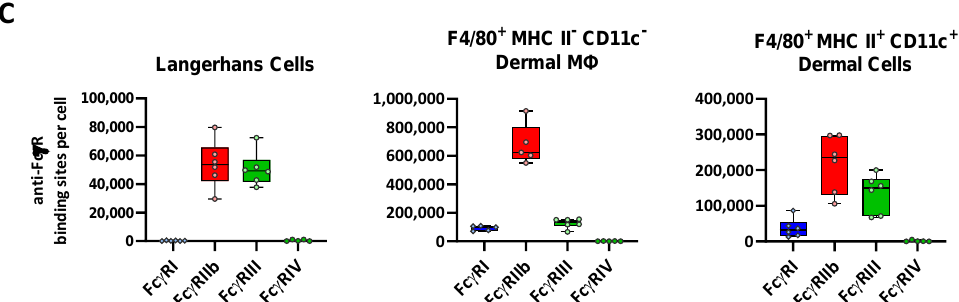
Figure 5. Characterization of the Fc γ R expression on skin macrophage subsets. ( A ) Shown is the gating strategy for the identification of Langerhans cells. CD45-positive populations among single viable cells from an enzymatically digested epidermis were examined for expression of the surface markers CD11b and F4/80. Among CD11b and F4/80-double-positive cells, Langerhans cells were identified by a pronounced expression of Langerin. The histogram inset in the right panel depicts their MHC II expression by comparing the fluorescence in the samples without (FMO, grey histogram) and with anti-MHC II antibody (blue histogram). ( B ) Gating strategy for Langerin-negative F4/80-positive dermal cells. Single viable cells from enzymatically digested and dermis-enriched skin were analyzed regarding their CD45 and Langerin expression to exclude Langerhans cells among the CD45-positive leukocytes. Among the CD45 + Langerin-negative cells, two subpopulations within the CD11b and F4/80-positive cells were distinguished based on a high or low level of MHC II expression (depicted in blue or red), respectively. Both population were then examined for CD11c expression. Inset: Microscopic analysis of the sorted MHC II − CD11c − DM. ( C ) Depicted is the ABC for each FcγR per cell as a quantitative correlate of the individual FcγR numbers. Data are presented as box plots showing the median and interquartile range and whiskers depicting extremes together with all single values. n = 6 or 5 upon the exclusion of single outliers according to the Grubbs’ test with alpha = 0.1.